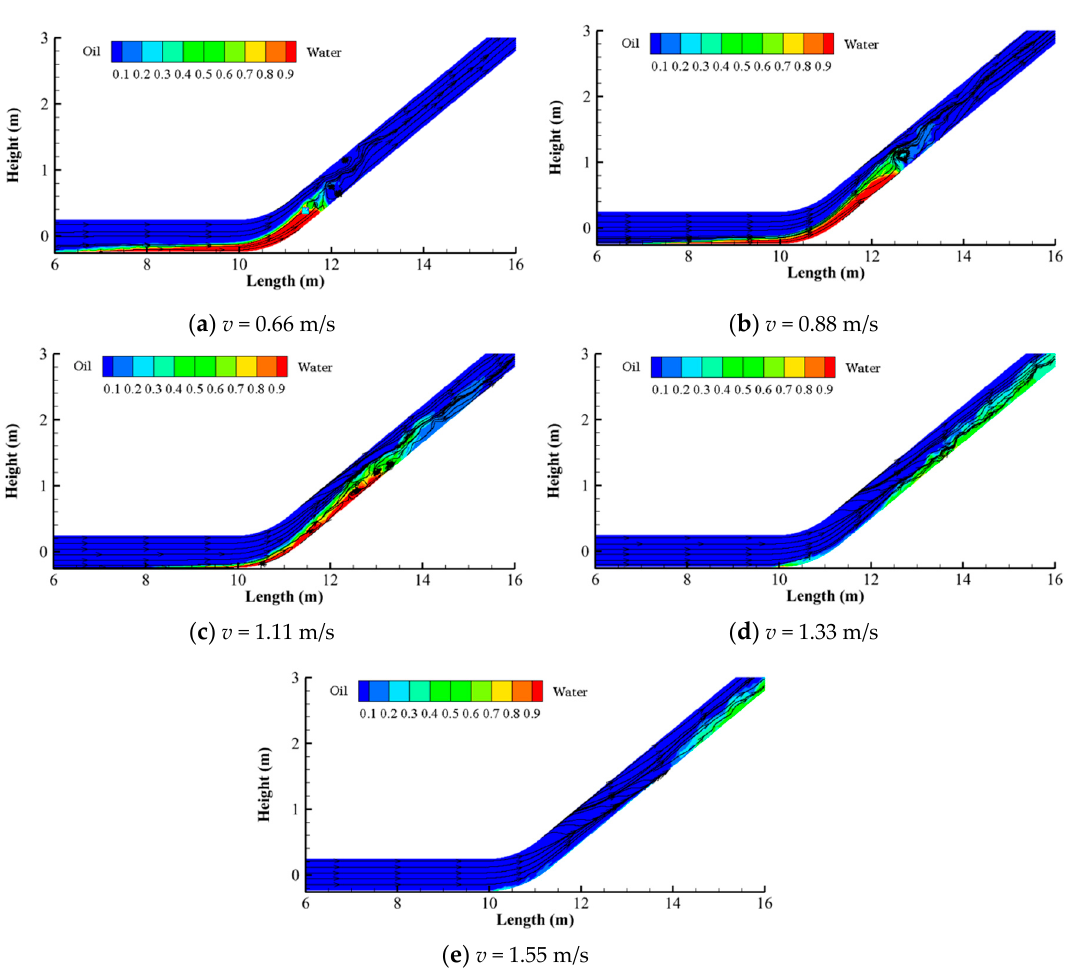
Figure 12. Distribution of oil and water ( α = 30°, t = 11.0 s).